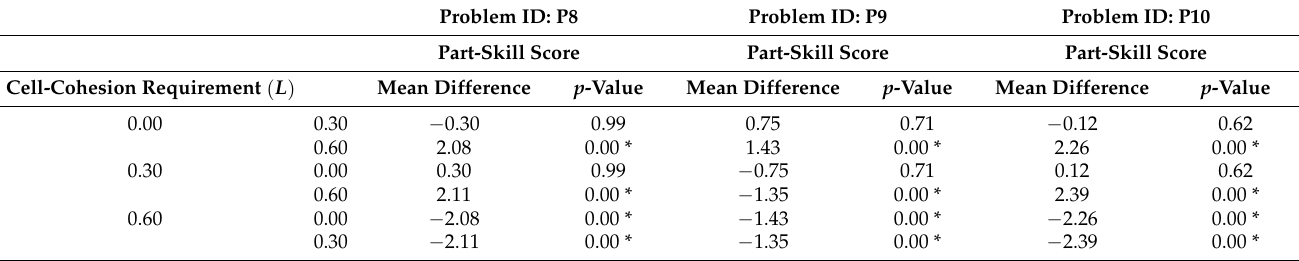
Table 18. Two-way ANOVA results on part-skill score.